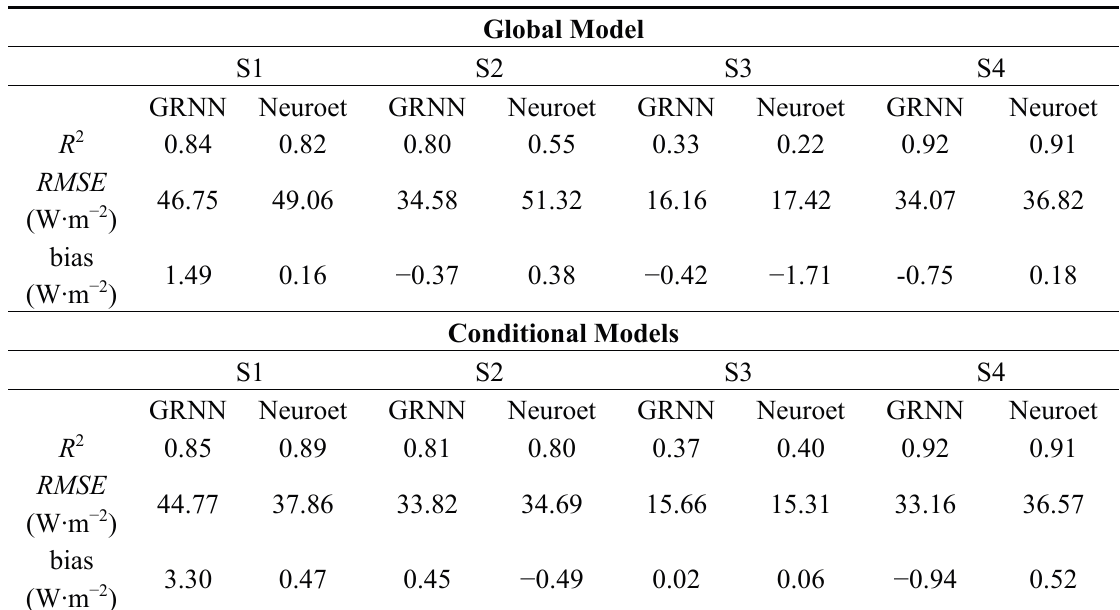
Table 6. Validation statistics for GRNN and Neuroet global and conditional models for the four